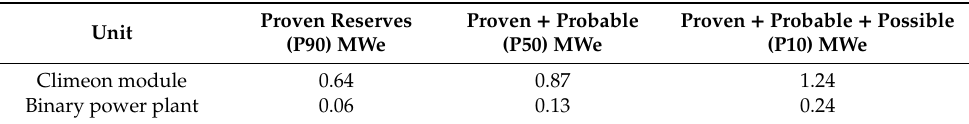
Table 5. Results of the Monte Carlo simulation for Longroiva for both the Climeon module and binary power plant.